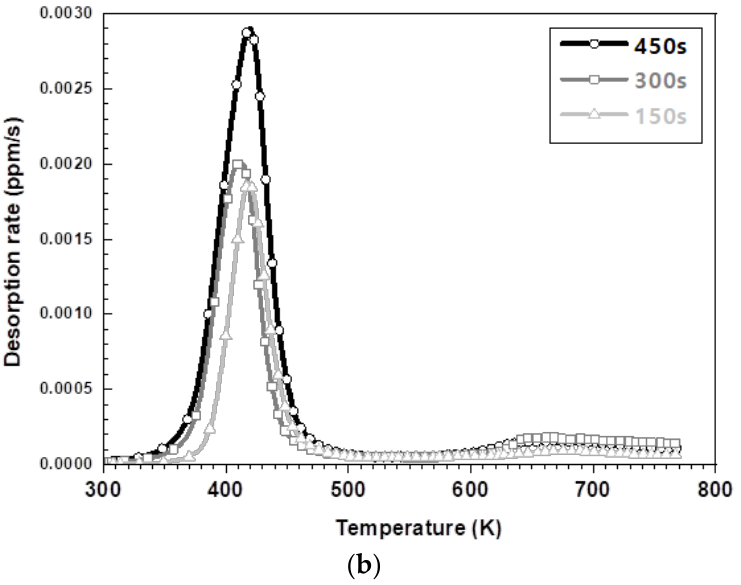
Figure 6. The TDS curves depending on keeping time in furnace: ( a ) the desorption curve in the 1.5 GPa grade and ( b ) the desorption curve in the 1.8 GPa grade.